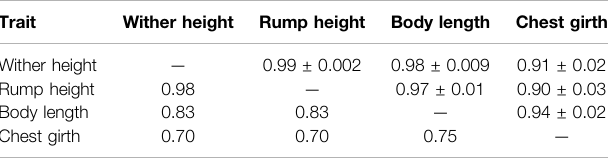
TABLE 2 | Estimated proportions of variance components ± standard errors for type traits in the fi rst parity Cika cows. Traits h 2